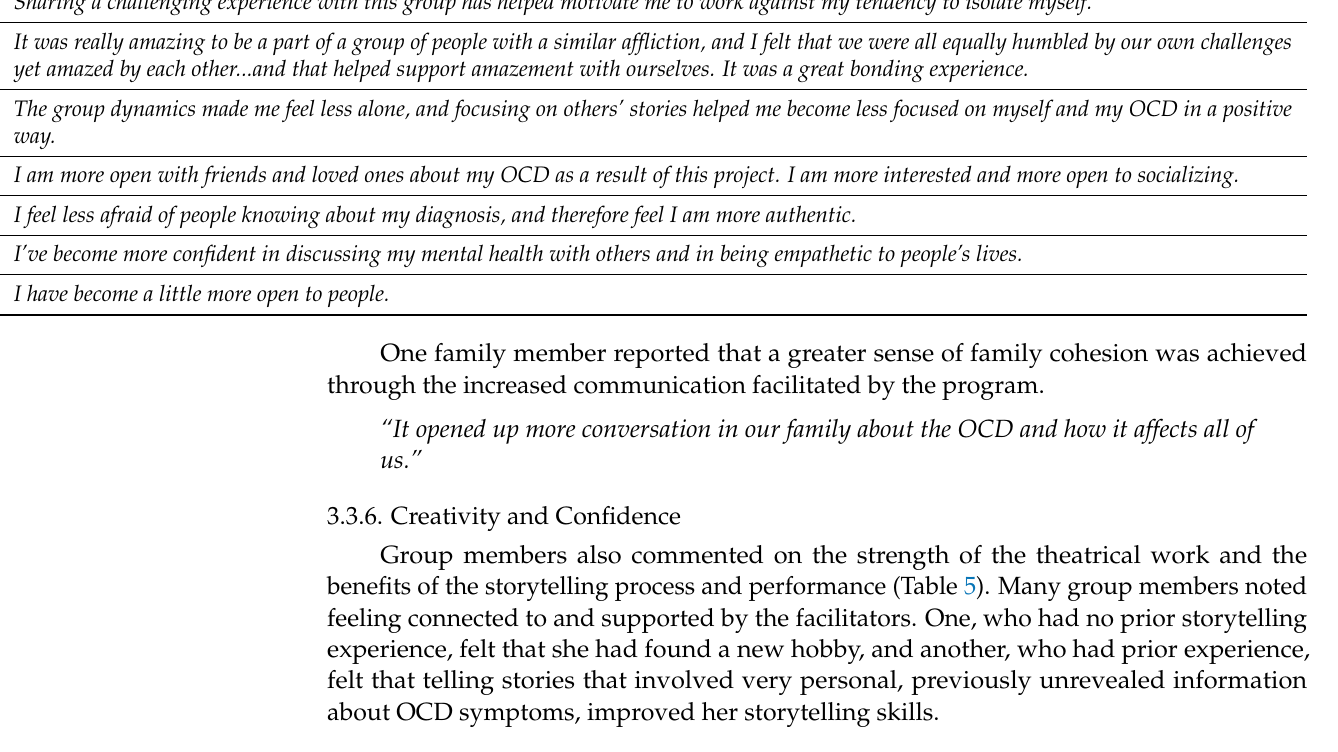
Table 5. Participant open-ended survey responses.